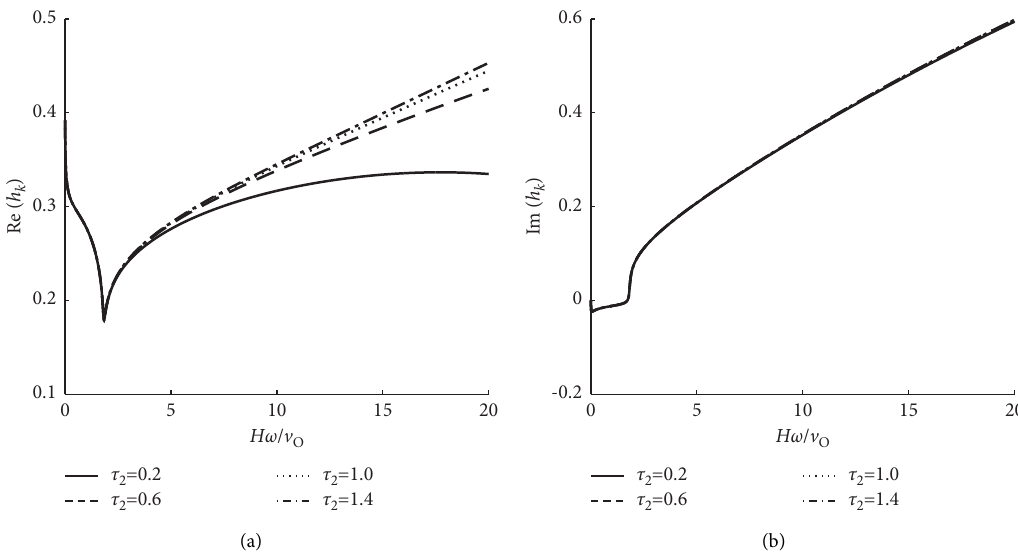
Figure 8: The impedance factor curves of soil layers under different model parameter ratios ( τ the soil layer. (b) Horizontal damping factor of the soil